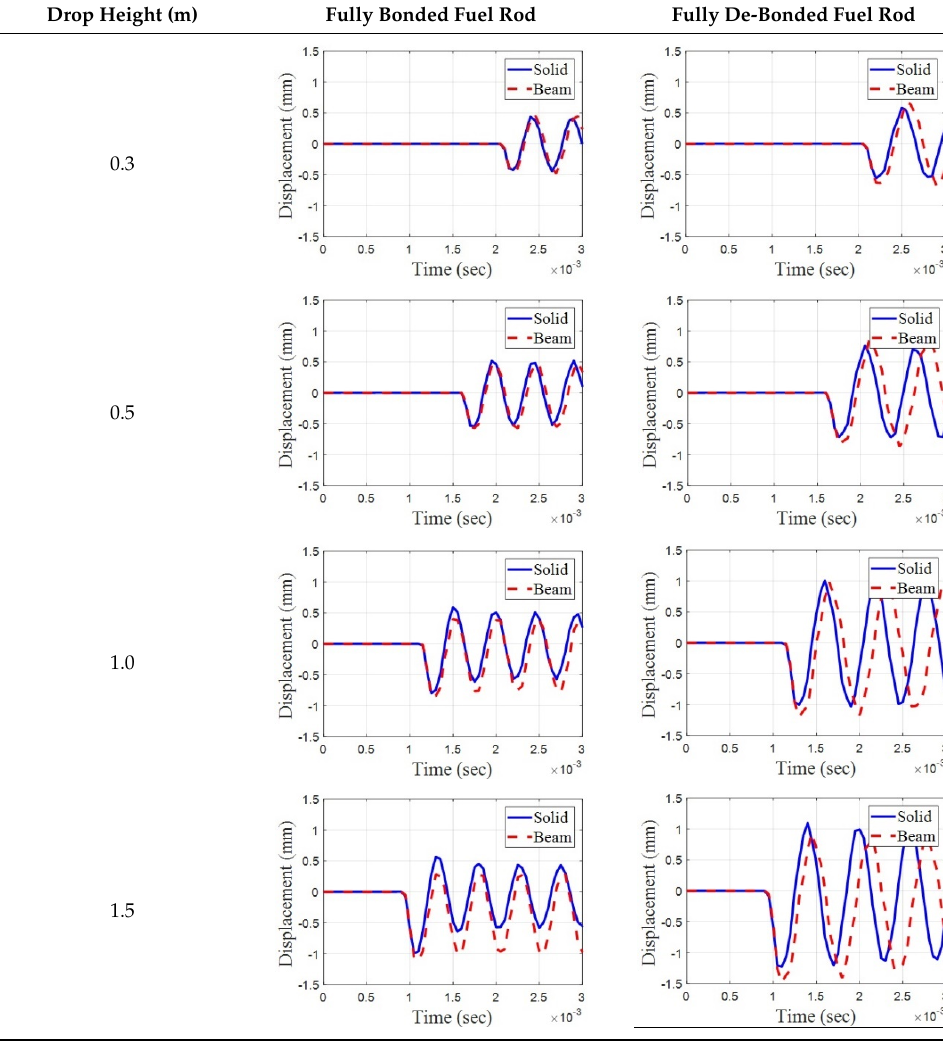
Table 9. History of the deflection of fuel rods calculated by dynamic impact simulations.